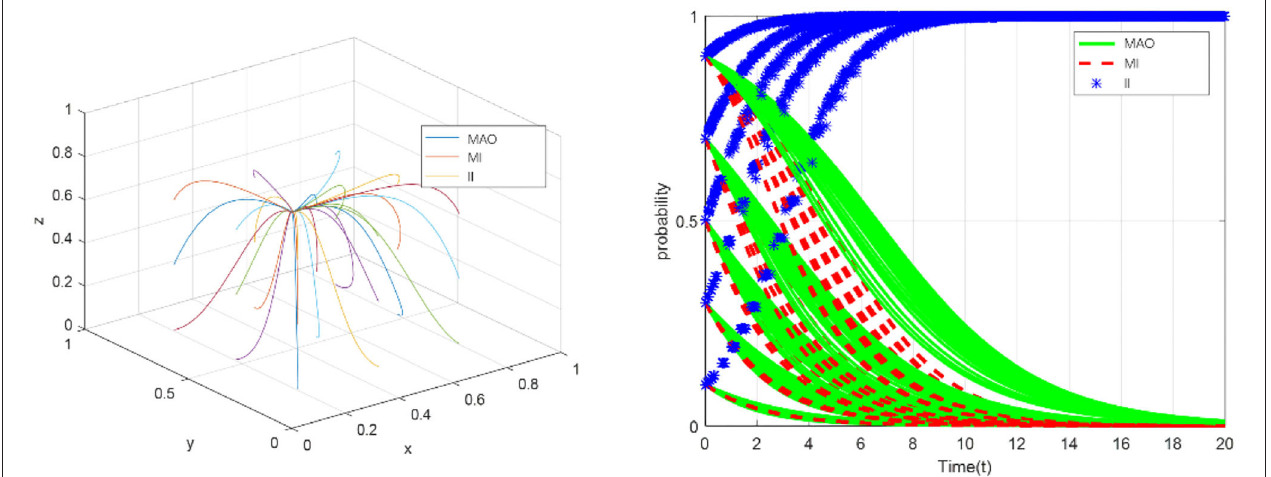
FIGURE 5 | The evolution toward the sink ESS